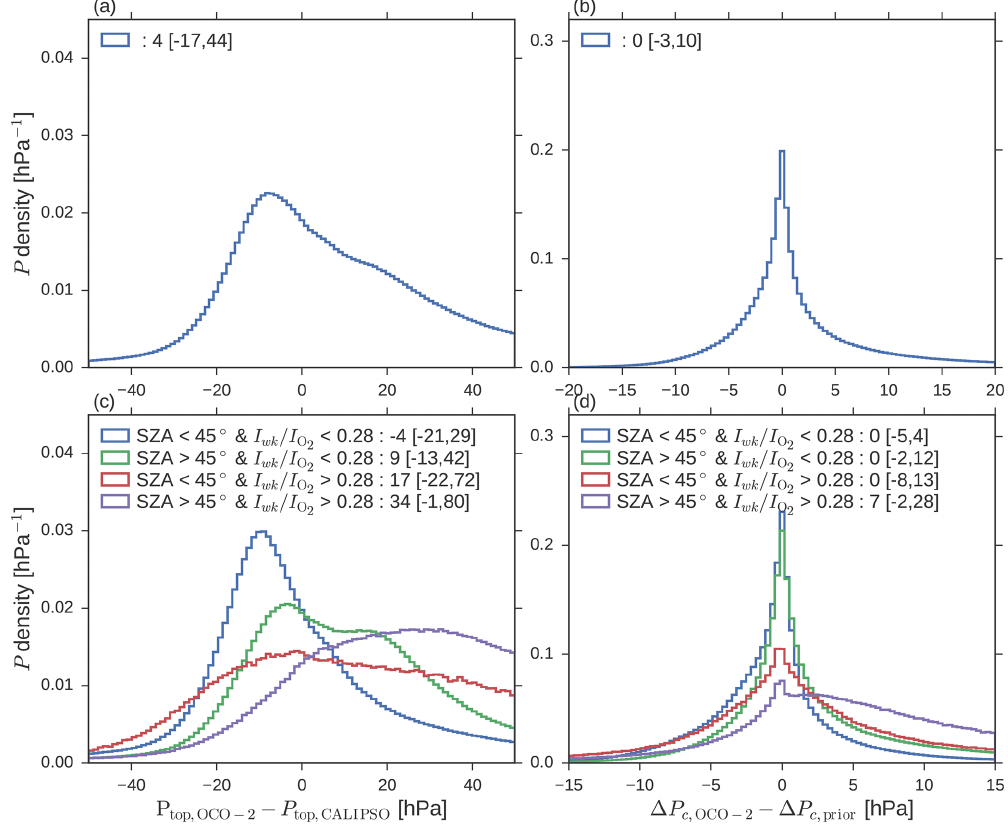
Figure 5. Posterior minus prior retrieval statistics; all legends report median [14th, 86th percentiles]. (a) All OCO-2 minus CALIPSO cloud top pressure. (b) All OCO-2 posterior minus prior cloud pressure thicknesses. (c) As (a) but subset by Quality_flag. (d) As (b) but subset by